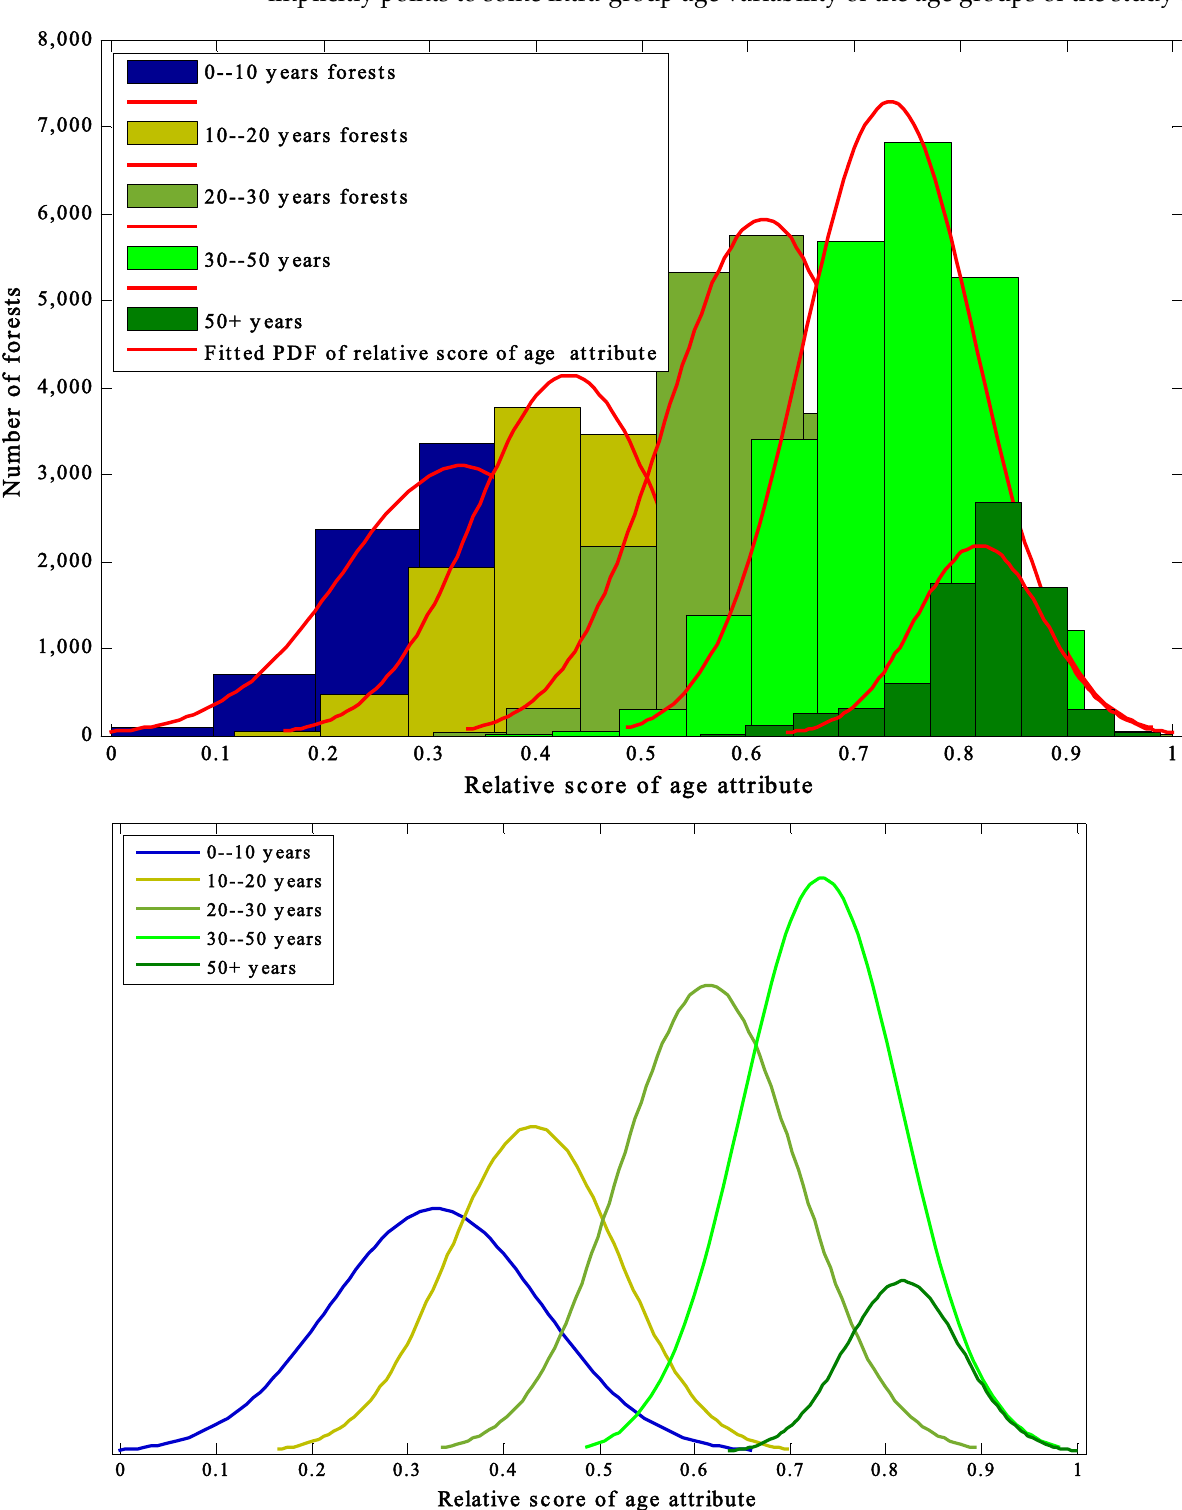
Figure 12. Statistical results generated based on the histogram of the relative scores of the successional age attribute assigned to each predicted age group by Sun et al. [35]. The top subfigure shows the PDF curves without the histograms shown in the bottom subfigure.